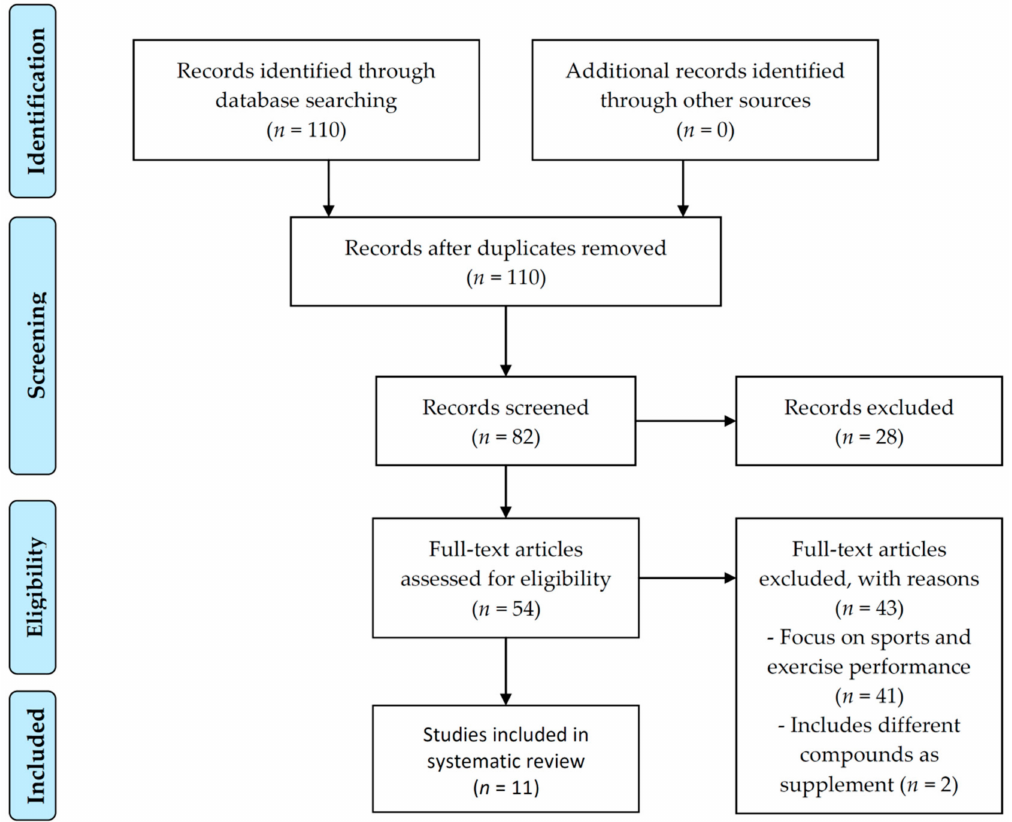
Figure 2. Preferred reporting items for systematic reviews and meta-analyses (PRISMA) flow